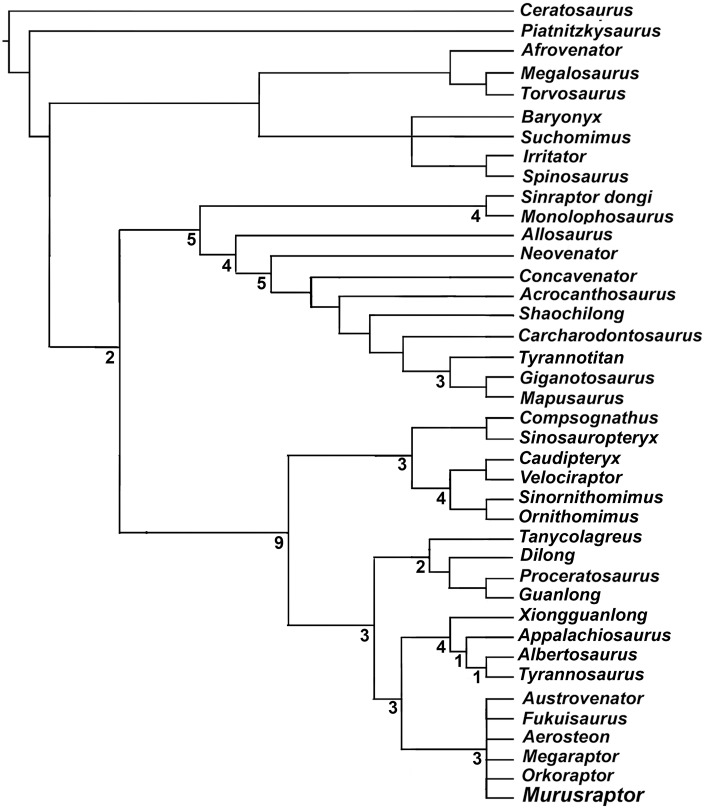
Cladogram depicting the phylogenetic position of Murusraptor according Analysis B.Numbers in nodes indicate Bremer support.